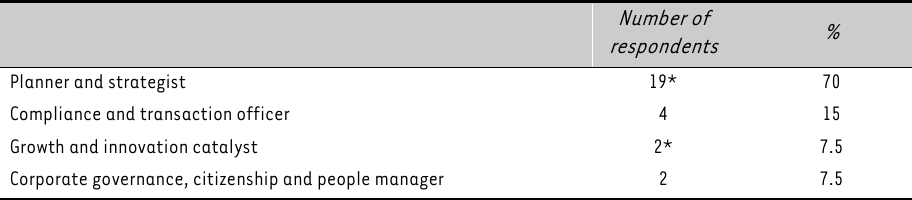
Number of % respondents